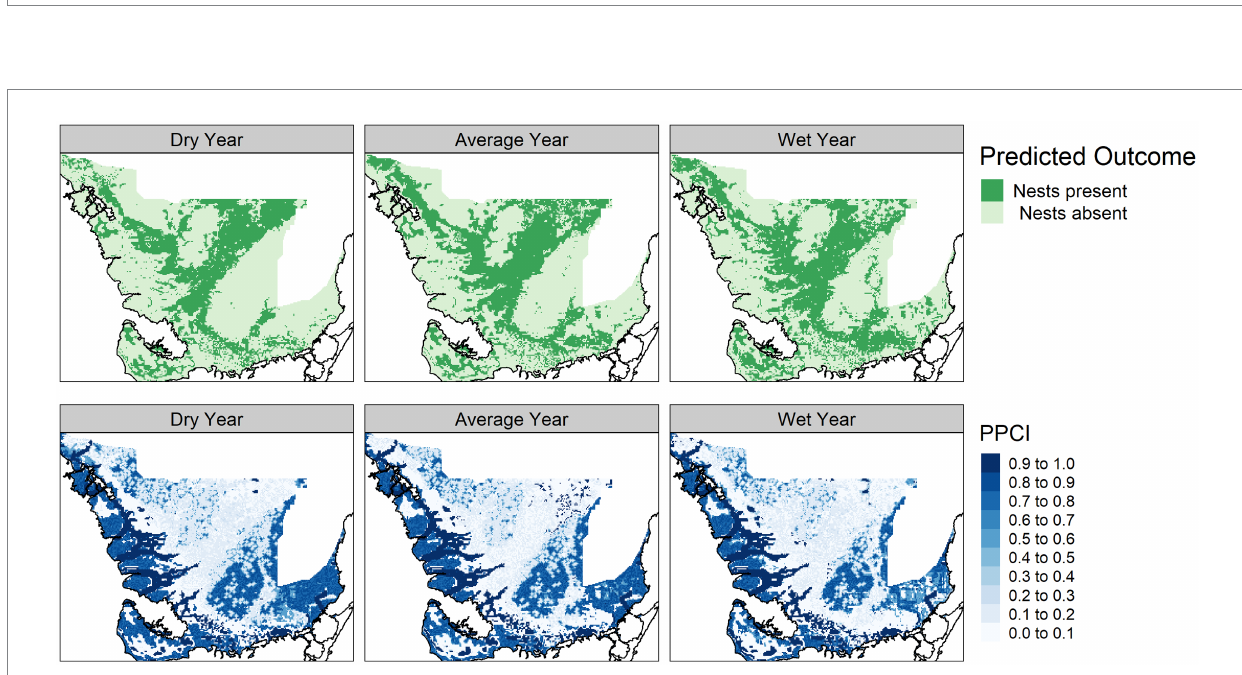
FIGURE 5 Predicted alligator nesting potential module outcome (top panel) and posterior probability certainty index (PPCI, bottom panel) for a dry (2014), average (2007), and wet (2003) year chosen from 2000 to